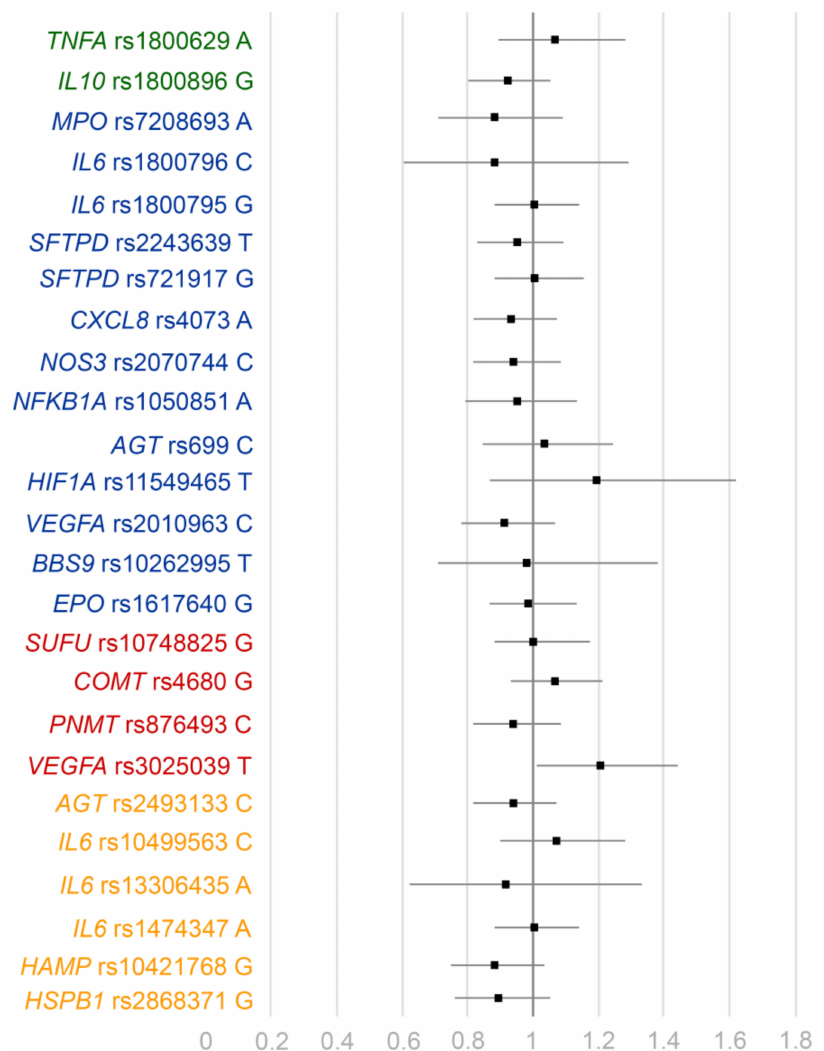
Figure 2. Odds ratios (OR) and confidence intervals (95% CI) for the minor allele for all the studied polymorphisms. For variants in green, there are several previous studies and both alleles have been reported to associate with AKI, variants in blue have been reported with same risk allele, variants in red have been reported with opposite risk allele, and variants in orange have not been previously reported in association to